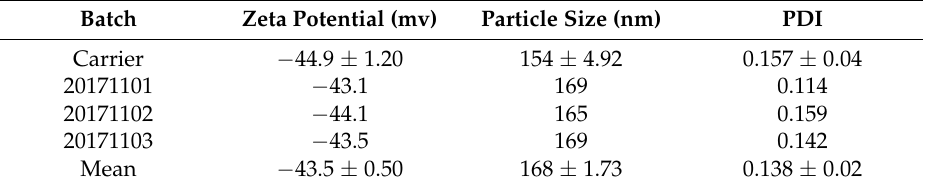
Table 8. Zeta potential and particle size of imperatorin lipid microspheres ( x ± s , n = 3).